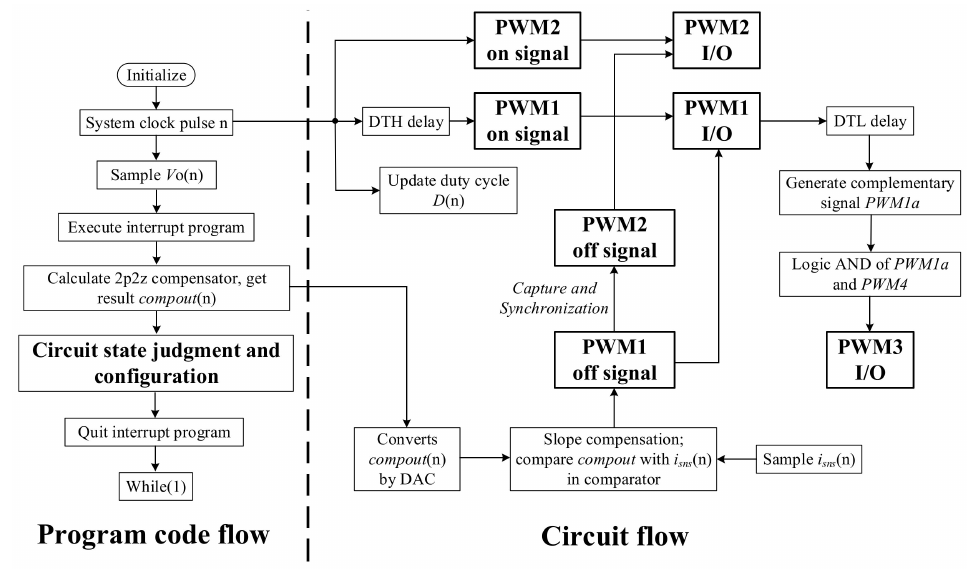
Figure 5. The control flow chart in DCM.